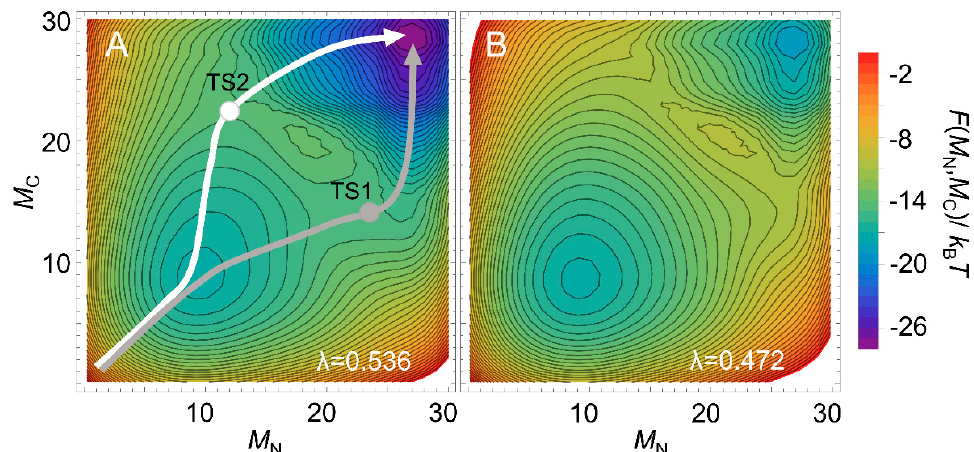
Figure 5. Two-dimensional free-energy landscapes of BdpA under folding conditions ( A ) and at the transition midpoint ( B ). The native structure of BdpA is shown in Figure 2 (left panel). M N and M C are the number of folded residues in the N-terminal half of BdpA (involving the first helix and the first half of the second helix) and C-terminal half of BdpA (involving the second half of the second helix and the third helix), respectively. Gray and white arrows denote the dominant folding pathways passing through the saddle points corresponding to the transition state 1 (TS1) and transition state 2 (TS2), respectively. λ = ε /( k B T ) is a parameter related to the uniform contact energy ε and temperature T . Adapted with permission from Ref. [26]. Copyright (2006) National Academy of Sciences, U.S.A.